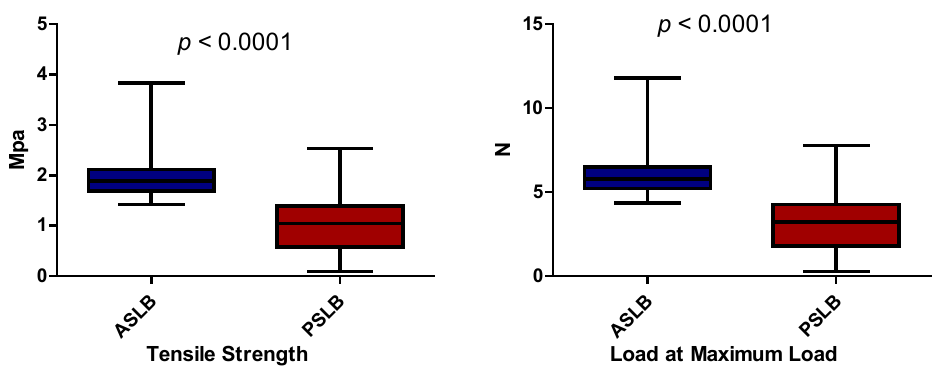
Figure 6. Maximum and minimum measured values for active and passive self-ligating brackets.